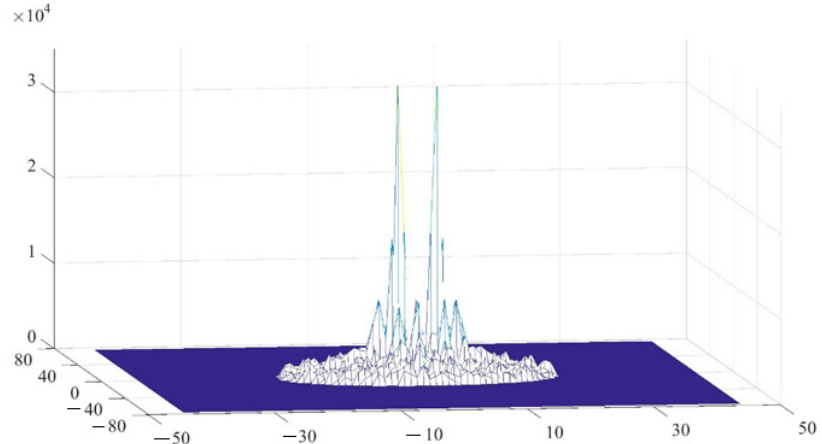
Figure 9. Filtered spectrum of the wave structure region. The two peaks denote the wave number of the gravity wave in Figure 8a. The two horizontal axes indicate the wavenumber along the x and y directions of the airglow image. The vertical axis is the power of grayscale image.